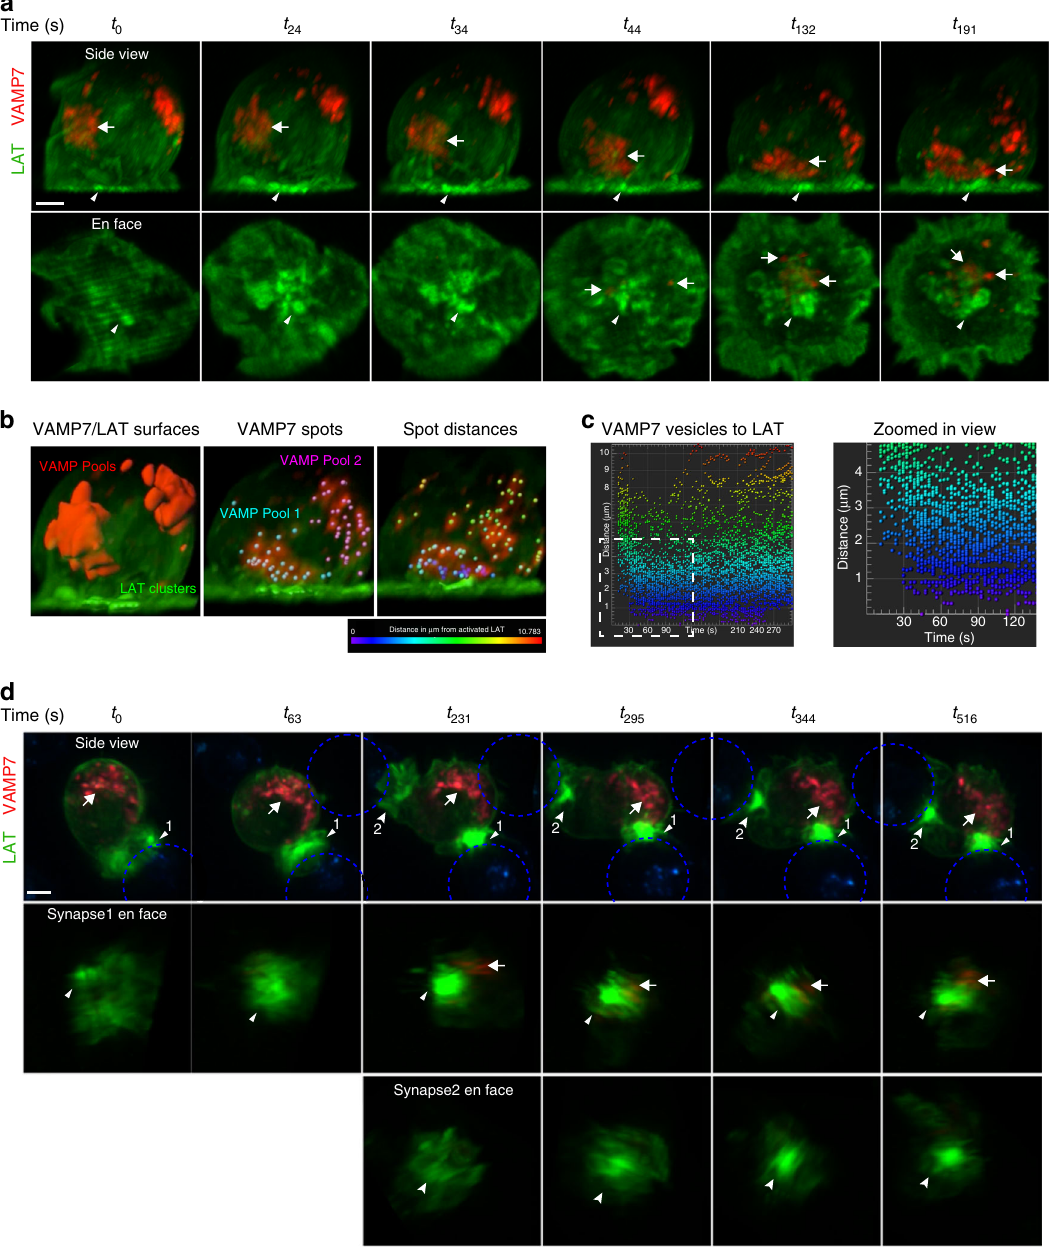
Fig. 3 Spatial and temporal dynamics of LAT and VAMP7 visualized by lattice light sheet microscopy. a Jurkat cells transfected with LAT-neon green (green) and Halo-VAMP7 (red) were dropped onto stimulatory coverslips and imaged by lattice light sheet microscopy soon after activation. t 0 indicates the fi rst time point of image collection. The top panel shows the side view of the cell. The arrowhead indicates LAT microclusters and the arrow indicates VAMP7 vesicles that colocalize with vesicular LAT. Scale bar equals 2 μ m. The bottom panel shows en face view of the activated surface ( n = 5 cells, three independent experiments). b The left panel shows surfaces of LAT clusters (green) and VAMP7 vesicles (red). The middle panel shows individual vesicles marked as spots (cyan and pink) within VAMP7 surfaces. The panel to the right shows distances of VAMP7 spots from LAT clusters followed over time. The vesicles are color-coded to indicate distance in μ m from activated LAT. c The panel to the left shows the graph of distances of individual VAMP7 vesicles from LAT clusters over time. Vesicles are color-coded to indicate distance in μ m from activated LAT as in b . To the right is the zoomed-in view of the white boxed region indicated in the graph. d Jurkat cells transfected with LAT-neon green (green) and Halo-VAMP7 (red) were incubated with SEE- coated Raji B cells (blue) and immune synapse formation was visualized by lattice light sheet microscopy. t 0 indicates the fi rst time point of image collection. The top panel shows the side view of the cell. The arrowhead indicates LAT aggregated at immune synapse 1, and the arrow indicates VAMP7 vesicles. At t 231 , the T cells begin to interact with a second Raji B cell. The second synapse is indicated with an indented arrowhead (synapse 2). Scale bar equals 2 μ m. The middle panel shows en face view of synapse 1 showing LAT accumulation at the immune synapse before the appearance of VAMP7 vesicles at t 231 . The bottom panel shows en face view of synapse 2 ( n = 5 cells, three independent experiments). See also Supplementary Figure